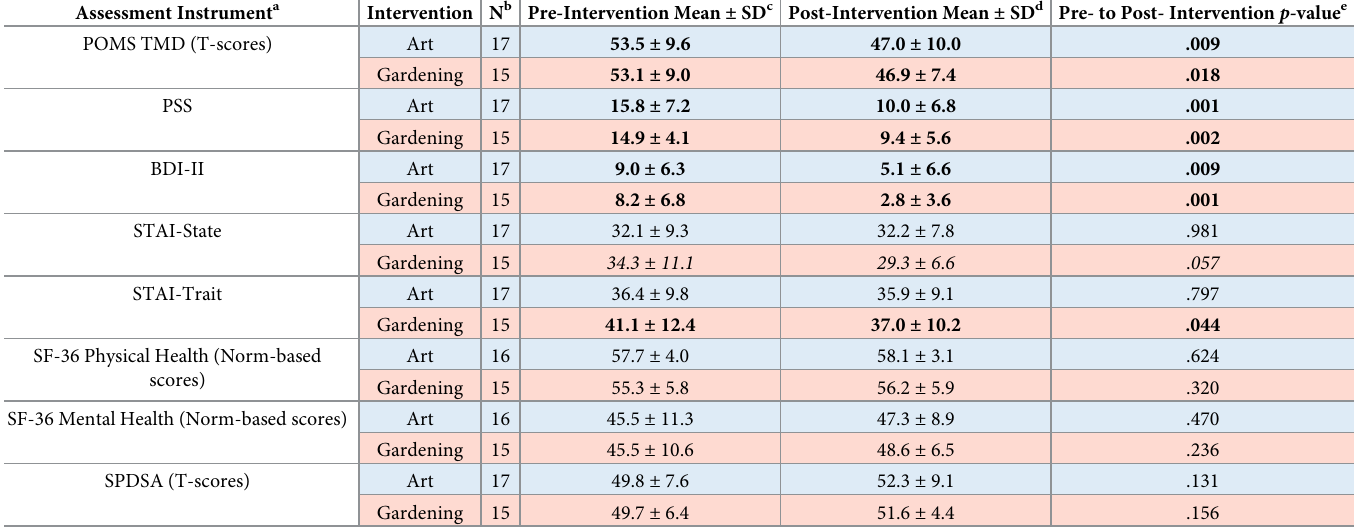
Table 5. Art and gardening groups self-report psychometric assessment statistics. Values computed from time by intervention group repeated measures pair-wise t - tests. Assessment Instrument